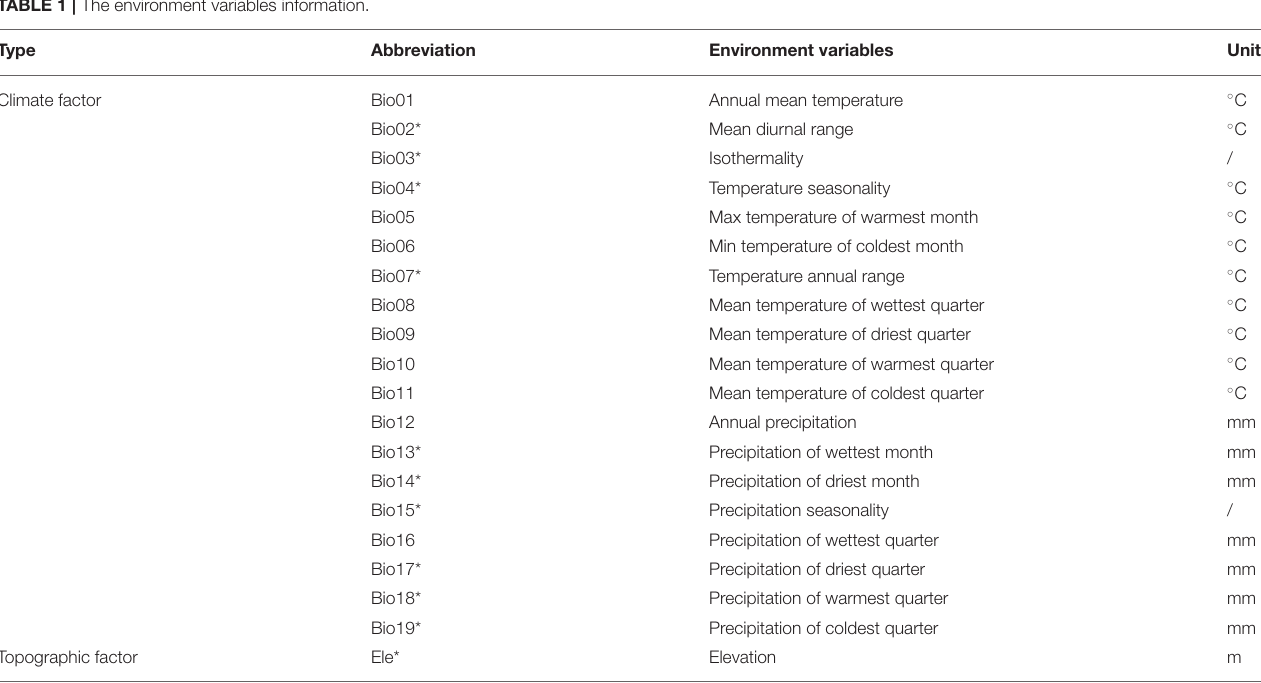
TABLE 1 | The environment variables